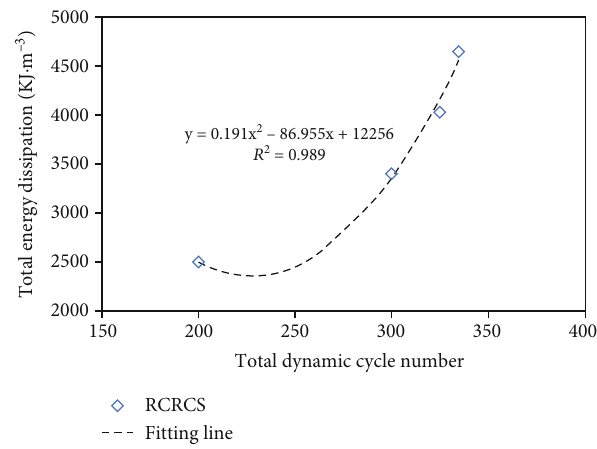
Figure 10: Relation of total amount of energy dissipation and total dynamic cyclic